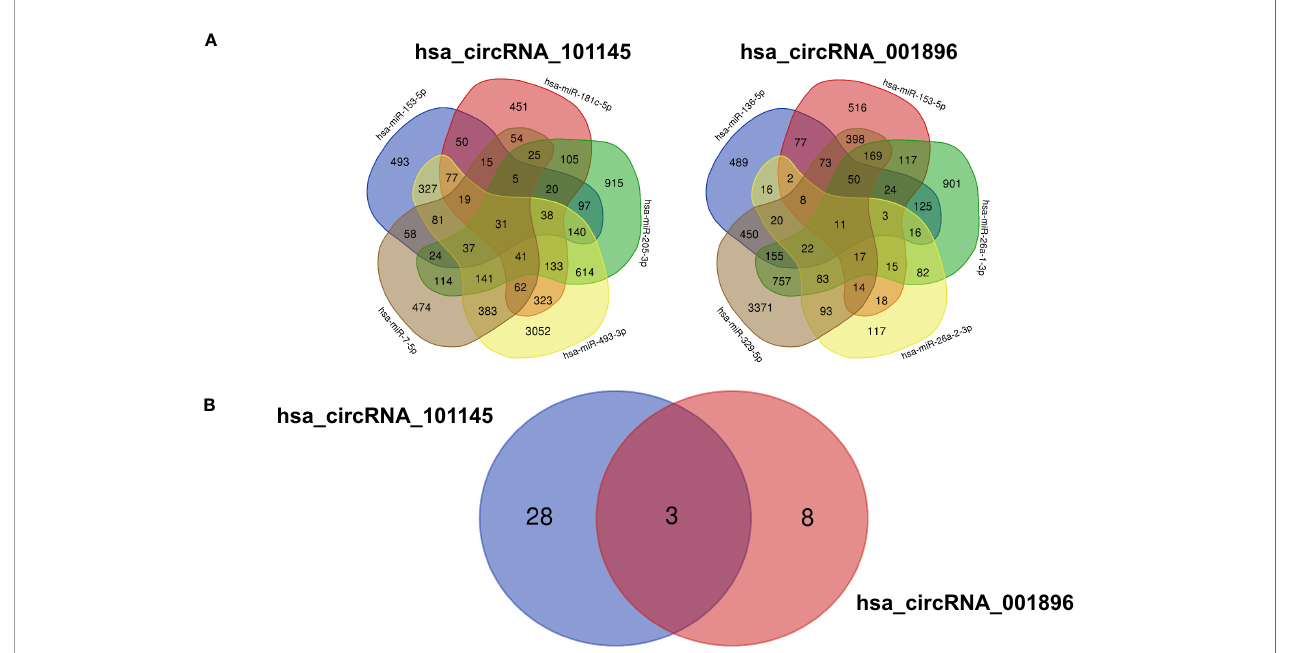
FIGURE 5 | mRNA predicted from miRNA identi fi ed as interacting with circRNA. (A) The Venn diagrams display the overlap of the mRNA predicted from the hsa_circRNA_101145-regulated miRNA (hsa-miR-153-5p, hsa-miR-7-5p, hsa-miR-493-3p, hsa-miR-205-3p, hsa-miR-181c-5p) and hsa_circRNA_001896-regulated miRNA (hsa-miR-329-5p, hsa-miR-26a-2-3p, hsa-miR-136-5p, hsa-miR-153-5p, hsa-miR-26a-1-3p). The fi gures indicate the number of overlapping mRNAs regulated by the corresponding miRNAs. (B) The Venn diagram of the overlapping mRNA regulated by all miRNAs predicted to interact with hsa_circRNA_101145 and hsa_circRNA_001896. Figures indicate the number of overlapping mRNAs regulated by all miRNAs predicted from a single